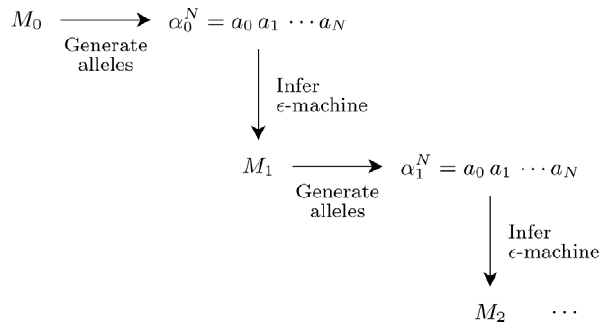
Figure 5. Sequential inference with a chain of -machines. An initial population generator M 0 produces a length- N string ~ a a N 1 ... a N from which a new model M 1 is inferred. These steps 0 are repeated using M 1 as the population generator and so on, until a terminating condition is met.